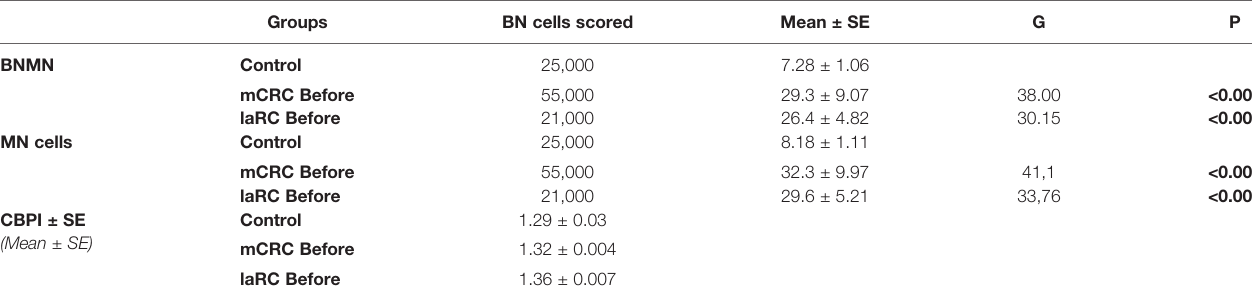
TABLE 2 | Statistical analysis of the mean BNMN and MNf of healthy controls and (A) mCRC/laRC patients at the beginning (before).